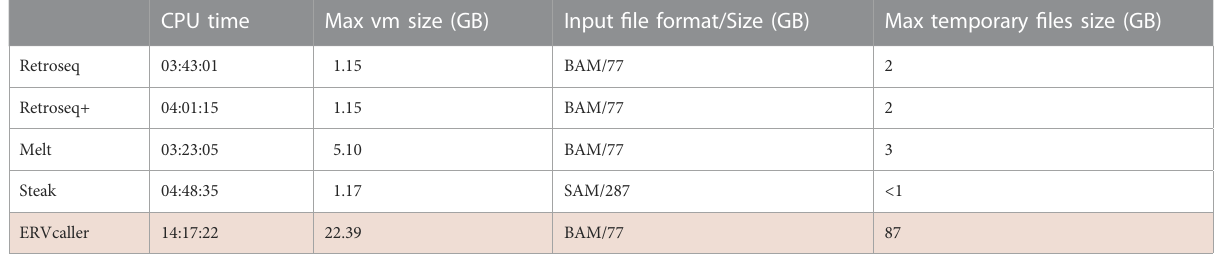
TABLE5Thistableshowshowmemoryisusedbyeachtool.TheCPUtimeisequaltothenumberofCPUs*time.MAXVMsizeisthemaximumvirtualmemory used at any one time by any part of the job. The input fi le size column reports the size of input sequencing data in the format required by each tool. The Max Temporary Files Size shows the maximum temporary storage required by each tool while running. For tools where there is an option to remove (clean up) temporary fi les, this option was not used. Lowest performing tool is highlighted in